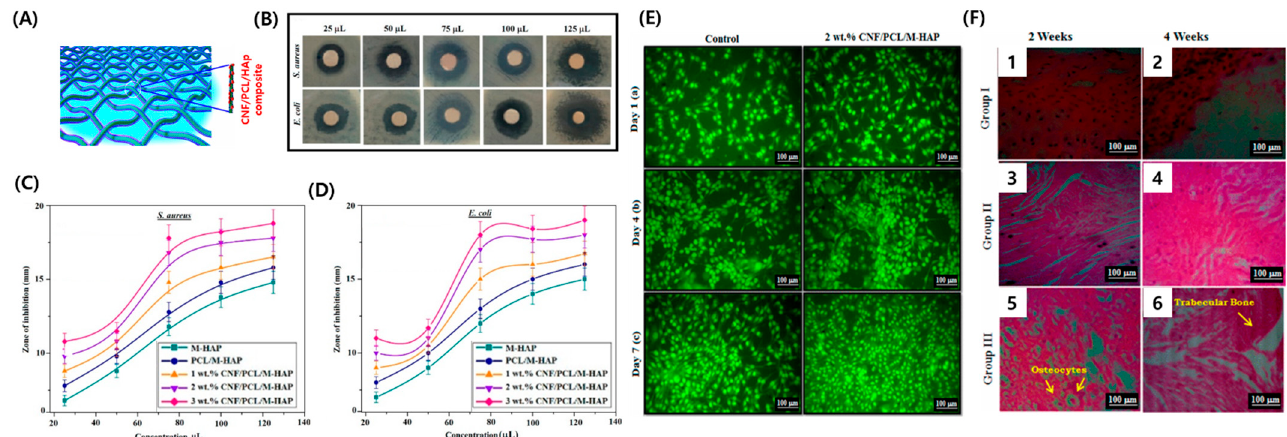
Figure 3. ( A ) Formation of a nanofibrous layer composed of CNF/polycaprolactone (PCL)/mineralized HAp (M-HAp) on Ti; ( B ) photographs of the zone of inhibition on 2 wt % CNF/PCL/M-HAp at different volume concentrations; ( C , D ) antibacterial effects on S. aureus and E. coli according to CNF concentration, respectively; ( E ) live/dead assay of MG63 cells cultured on control and 2 wt % CNF/PCL/M-HAp-coated Ti substrates; ( F ) toluidine blue-stained sections from the uncoated Ti group I (1,2), PCL/M-HAP-coated Ti group II (3,4), and 2 wt % CNF/PCL/M-HAP composite-coated Ti group III (5,6), taken after two and four weeks of implantation. Copyrights © 2017 American Chemical Society, Reference [31].